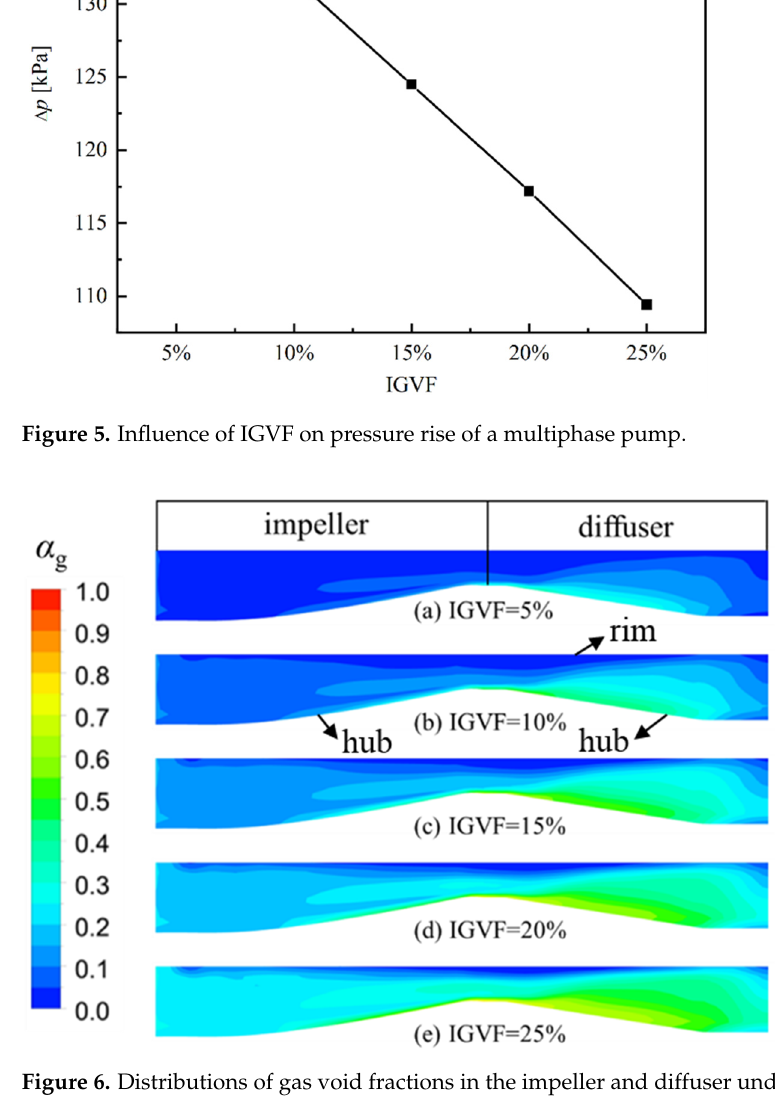
Figure 5. Influence of IGVF on pressure rise of a multiphase pump.